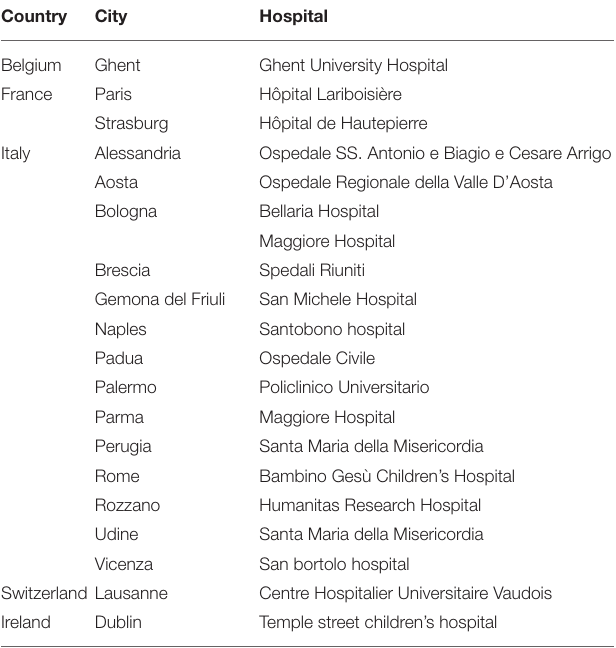
TABLE 1 | Centers involved in the study. Country